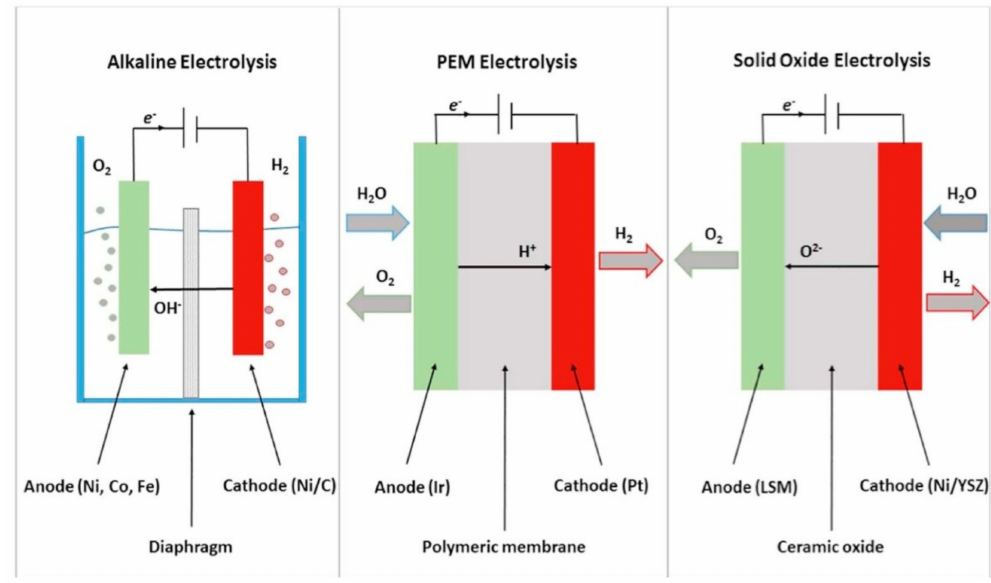
Figure 20. Operating principle of different types of electrochemical electrolysis. Reprinted from [193]. Table 4. Overall reactions at the anode and cathode with different electrolytic reactions [193].